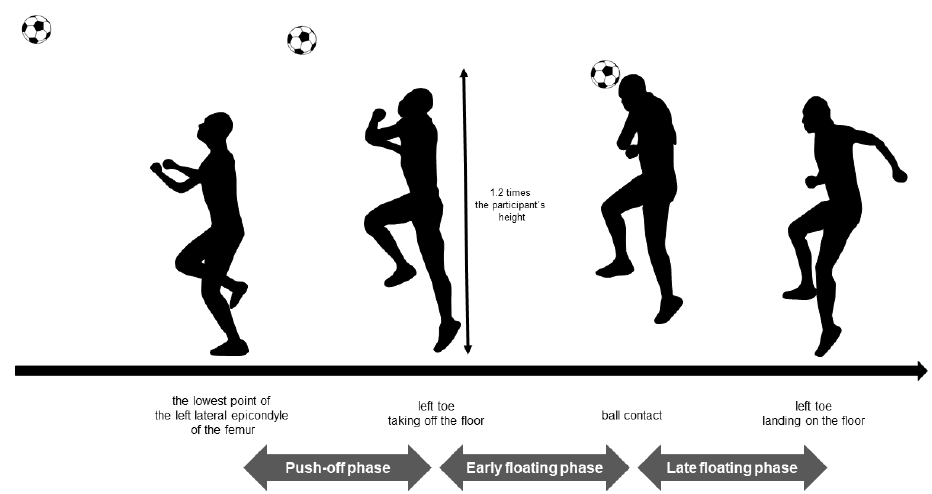
Figure 3. Phases of the jump header shooting. The target height of the soccer ball was set at 1.2 times the participant’s height at the take-off point.